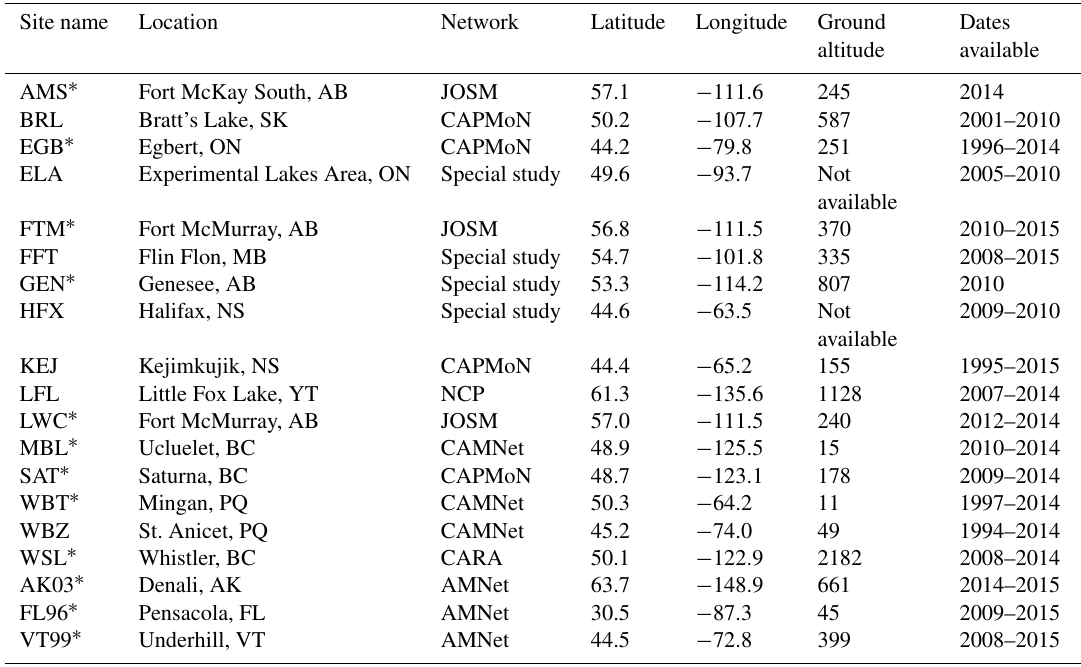
Table 1. Location of all Canadian observation stations and American stations where fire plumes were observed from 2010 to 2015. Full network names are given in the text. Sites that observed fires are indicated with an asterisk ( ∗ ). The end date is the latest date that data were available; the station may still be